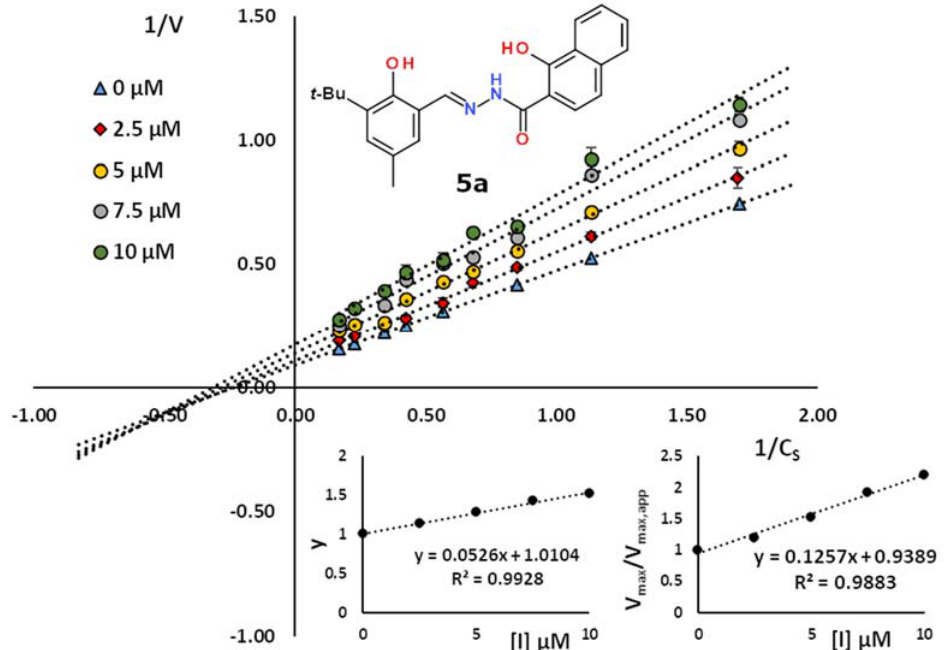
Figure 7. The Lineweaver–Burk plots (1/V [min · µ M − 1 ] = f(1/C S ) [ µ M − 1 ]) for 5a performed for the inhibitor concentration up to 10 µ M. The additional graphs show the linear dependence of K M,app · V max /( K M · V max,app ) = f(I) concerning the competitive component in a mixed type mechanism.